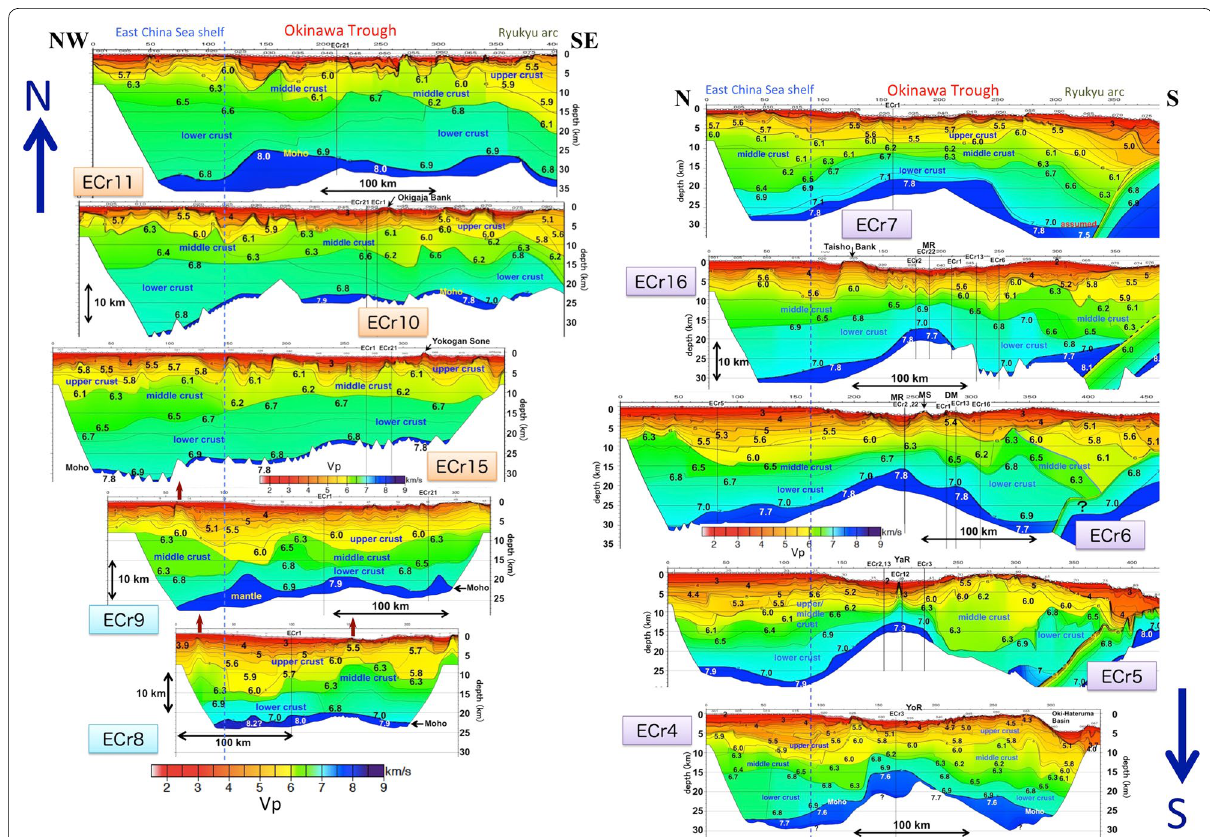
Fig. 5 P wave velocity models for the survey lines perpendicular to the trough axes. The contour interval is 0.25 km/s. These V p models were arranged from north to south and along the slope between the ECS shelf and the OT. The vertical dashed blue line shows the position of the northwestern edge of the OT. Upward arrows on ECr8 and ECr9 indicate ascending high V p materials in the top sedimentary layers. DM Daiichi– Miyako Knoll, MS Miyako Seamount, YoR Yonaguni Rift, YaR Yaeyama Rift, MR Miyako